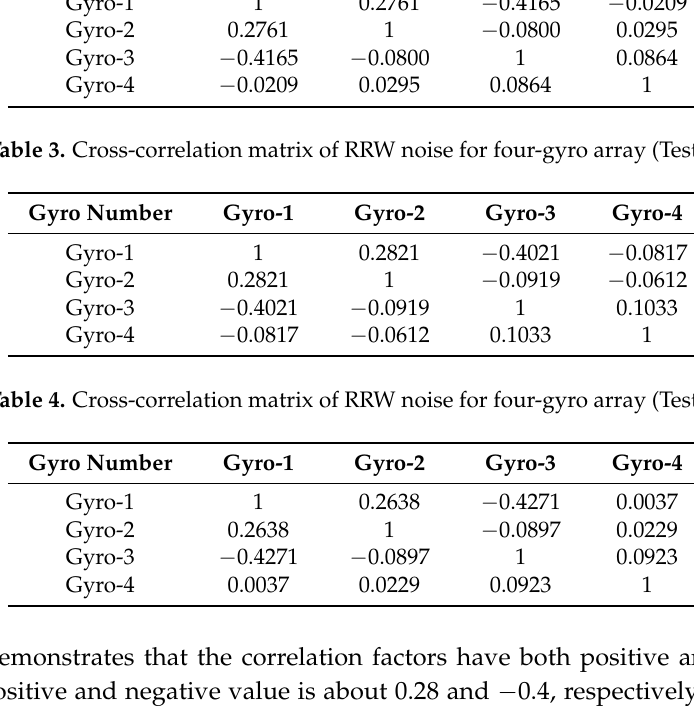
Table 2. Cross-correlation matrix of RRW noise for four-gyro array (Test 1). Gyro Number Gyro-1 Gyro-2 Table 3. Cross-correlation matrix of RRW noise for four-gyro array (Test 2).